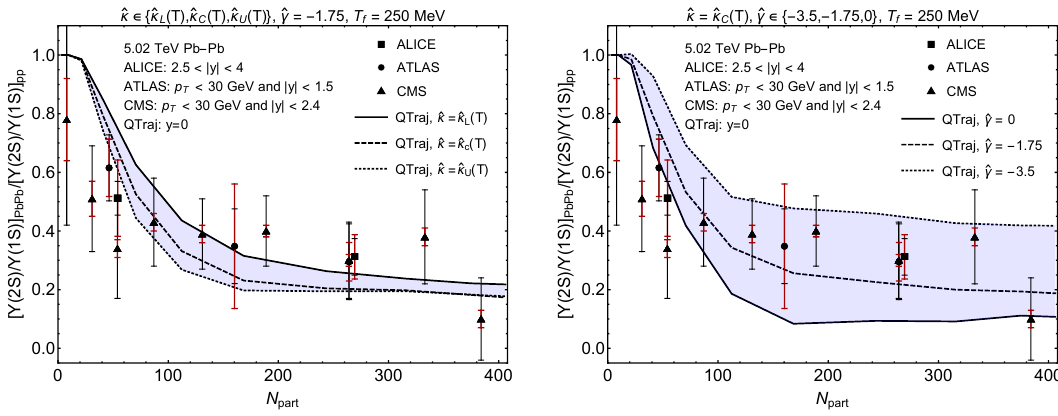
Figure 11 . Double ratio [Υ(2 S ) / Υ(1 S )] PbPb / [Υ(2 S ) / Υ(1 S )] pp as a function of N part . The bands shown in the left and right panels correspond to the variations detailed in the caption of figure 6. They account for the (anti-)correlations in the survival probabilities when varying ˆ κ and ˆ γ . The data points are from the ALICE [100], ATLAS [101], and CMS [102] collaborations. Systematic and statistical experimental uncertainties are indicated by red and black error bars, respectively.